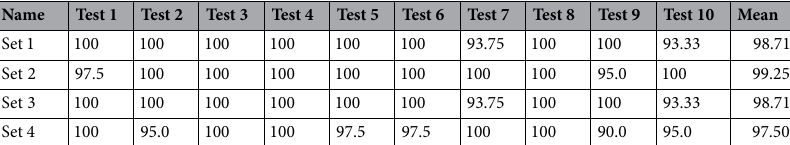
Table 7. Accuracy ( % ) result of the tenfold cross-validation obtained on the four subsets.